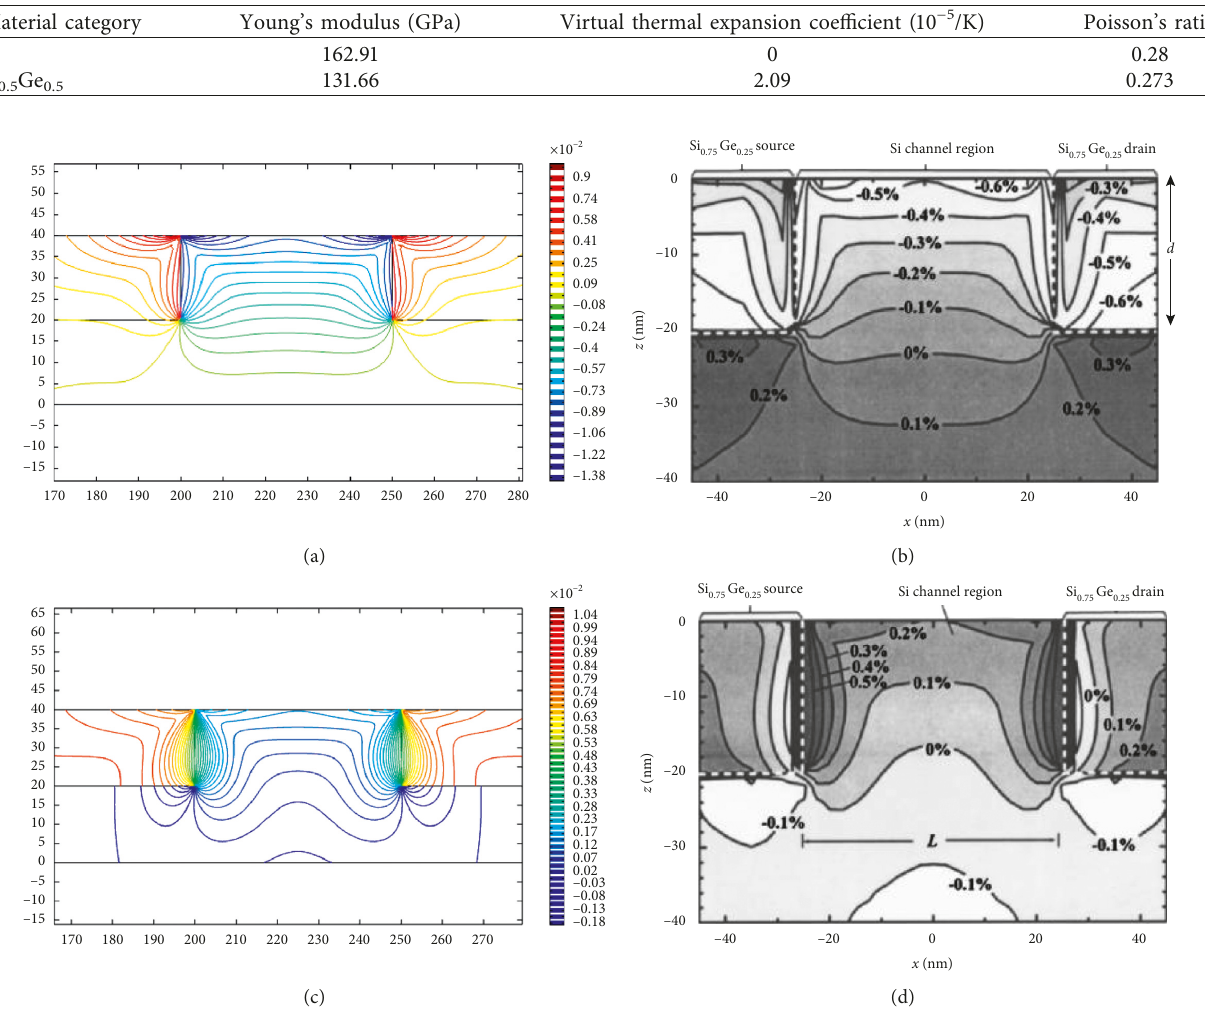
Table 1: COMSOL simulation parameters.